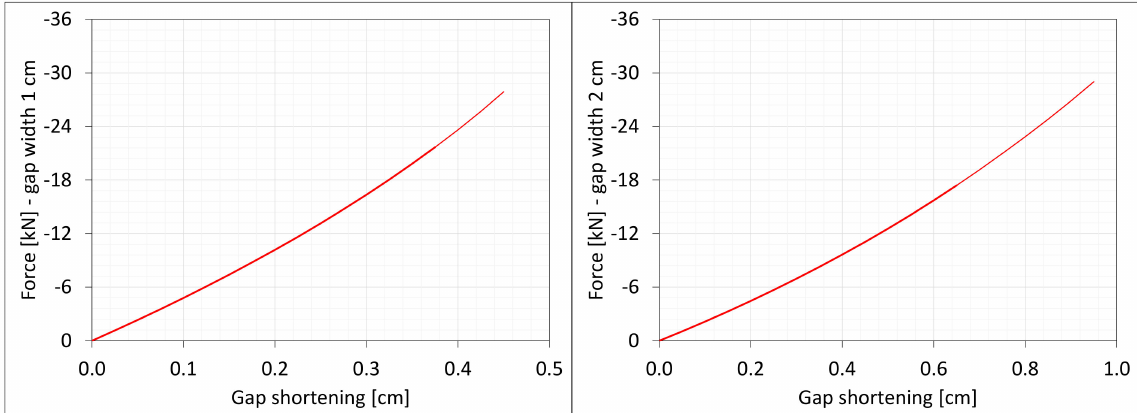
Figure 7. Equilibrium paths for excitation force N z . The width of the gap is equal to 1.0 cm, left graphic, and 2.0 cm, right graphic. Parts of charts with non-physical deformations are displayed with thin lines.